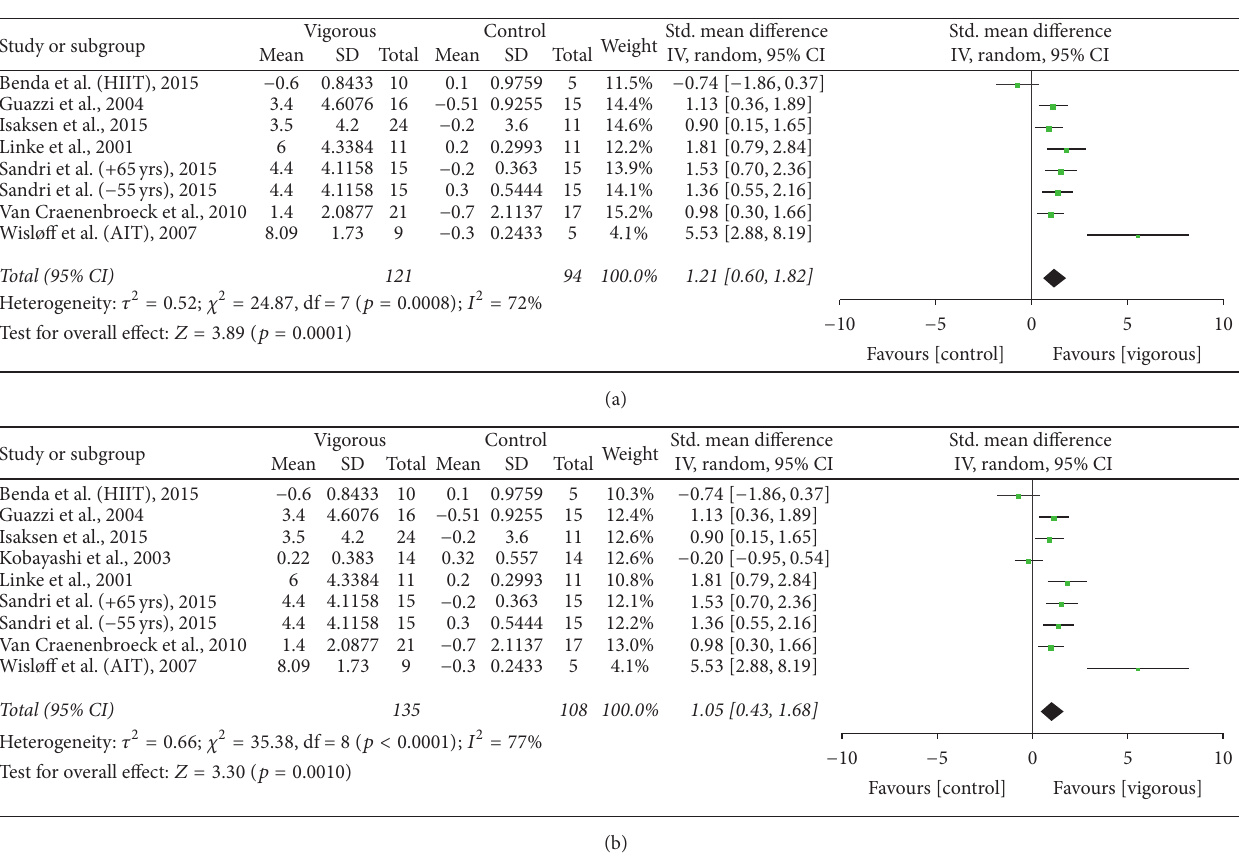
Figure 3: (a) FMD: vigorous aerobic training versus control. (b) FMD: vigorous aerobic training versus control (reallocation of Kobayashi from moderate to vigorous